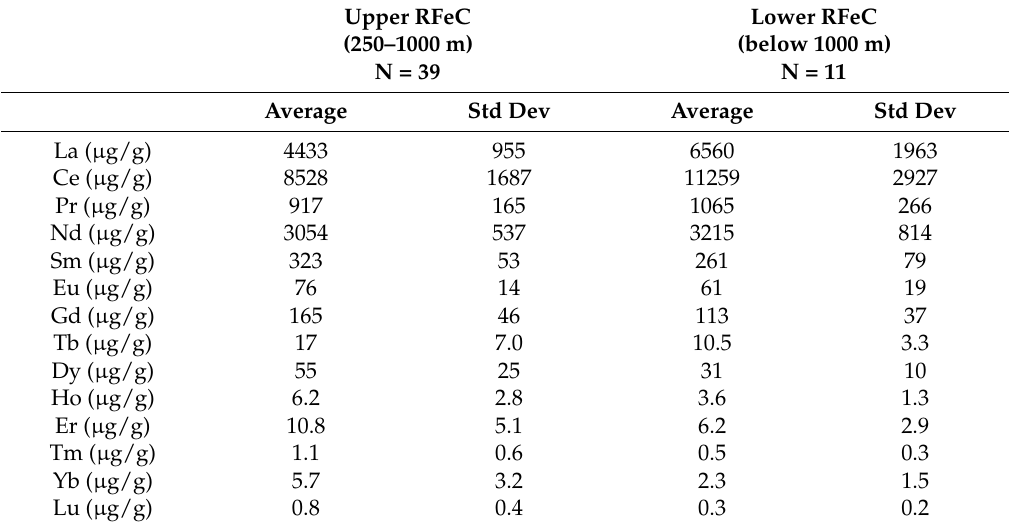
Table 2. Average REE concentrations and standard deviation of the average for the RFeC.